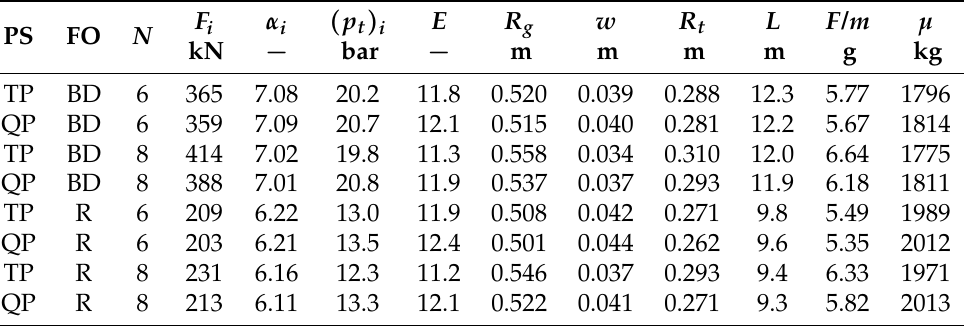
Table 3. Optimal design and performance for different port shapes (PS): triangular ports (TP) and quadrangular ports (QP). The second column reports the feed system option (FO): blow down (BD) and regulated (R). The design variables are F i , α i , ( p t ) i and E . R g , w , R t and L stand for grain outer radius, web thickness, throat radius and engine length, respectively. F / m is the maximum longitudinal acceleration imparted to the payload µ